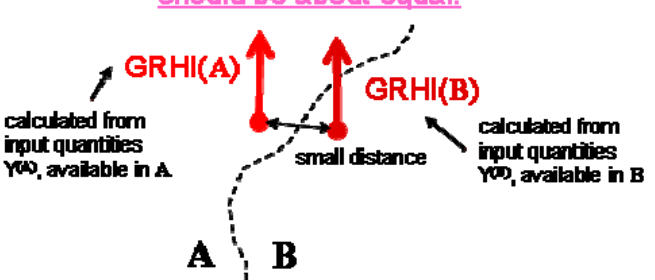
Figure 4. Consistency between quantity GRHI calculated in regions A and B from different sets of predictors, Y (A) and Y (B) .